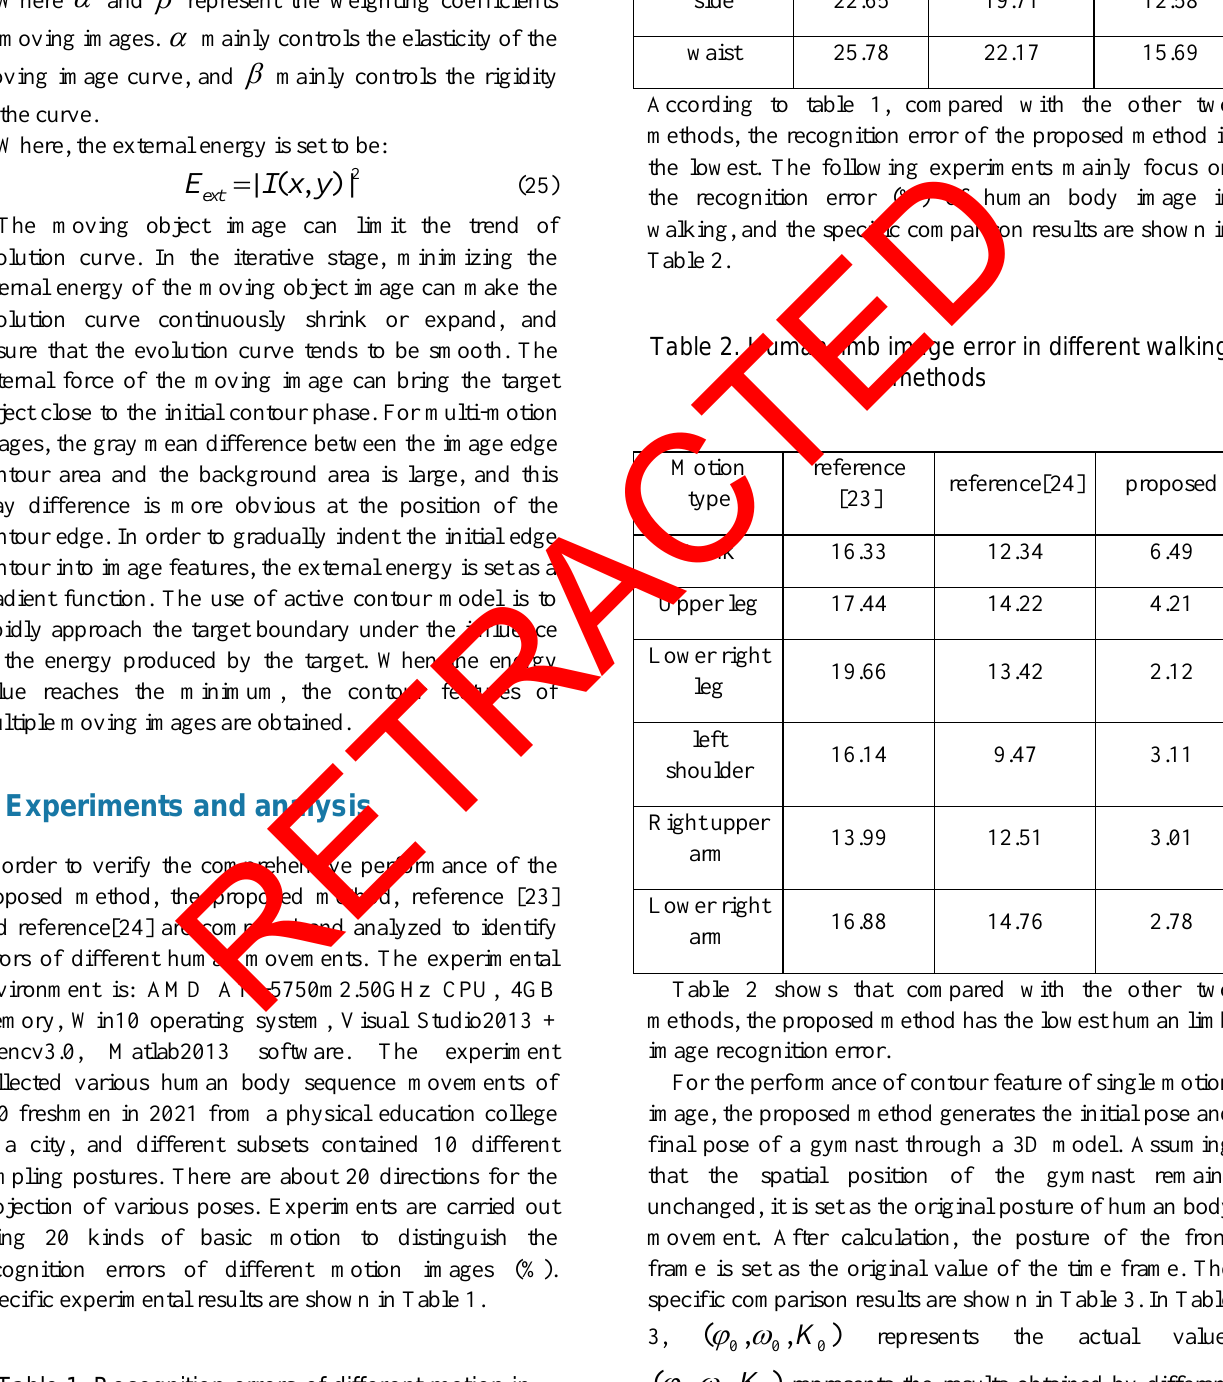
Table 1. Recognition errors of different motion in different feature extraction methods